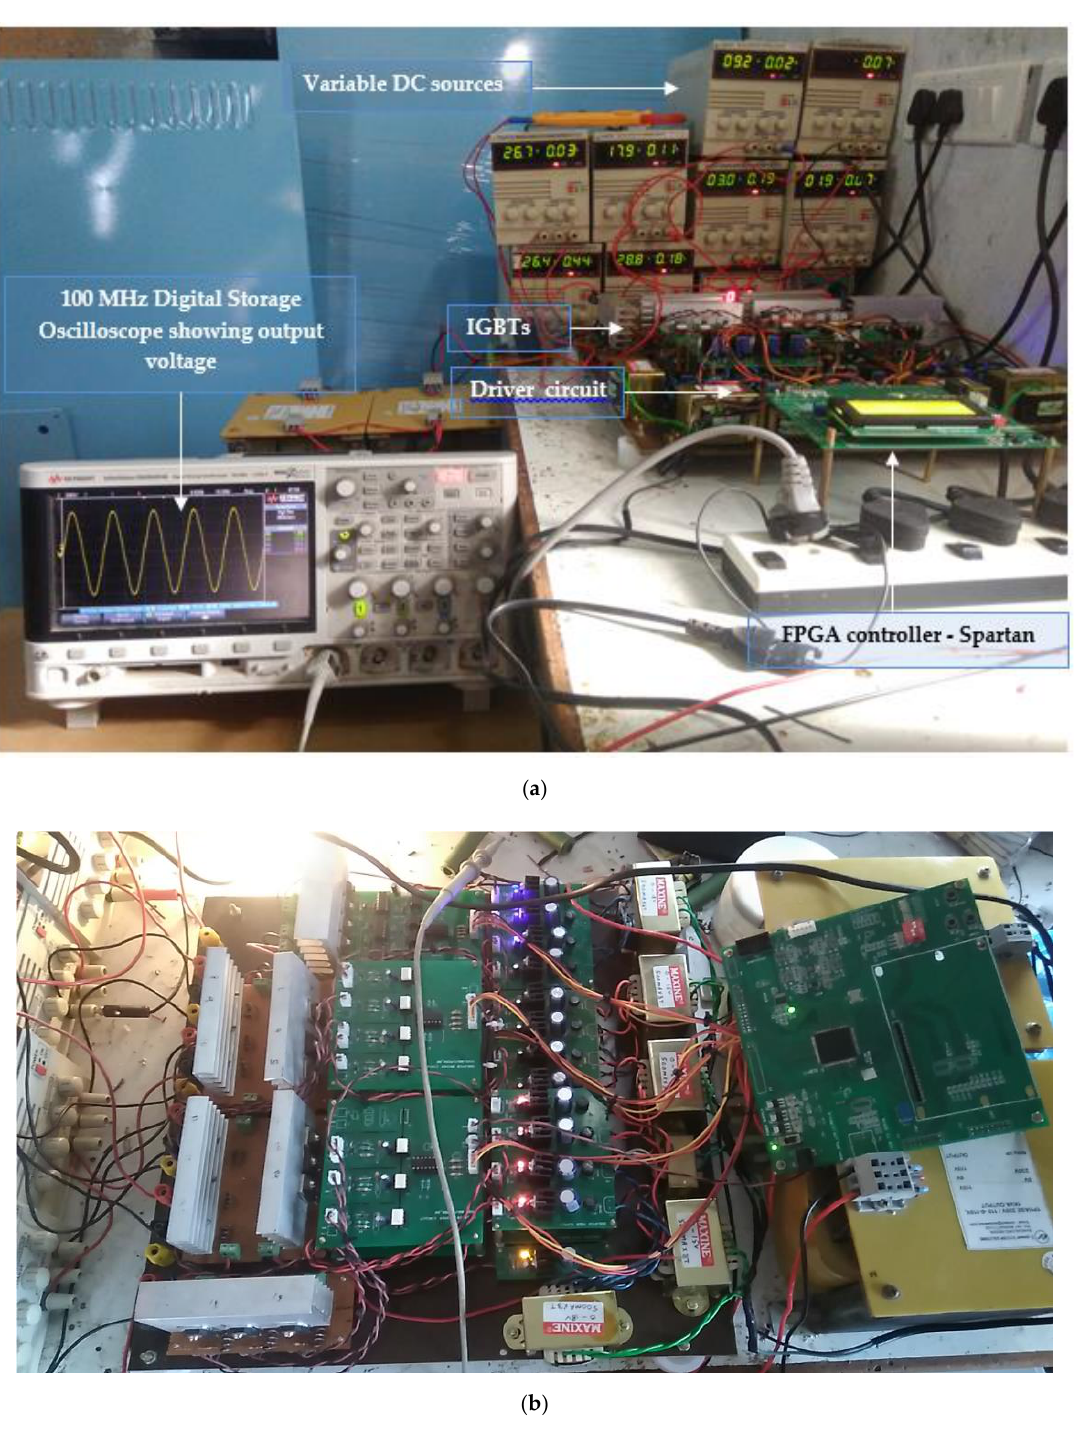
Figure 11. ( a , b ) Experimental development of 485 level inverter.